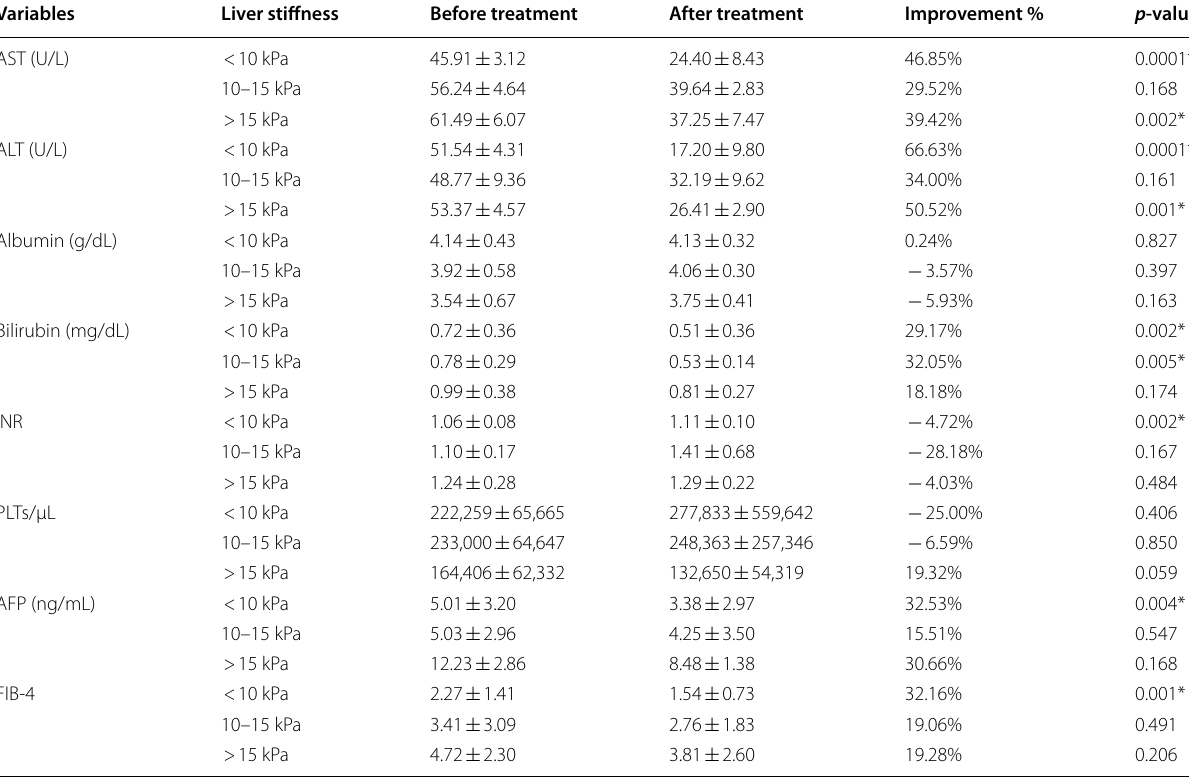
Data are expressed as mean standard deviation. p -value: probability value. *Significant ( p < ±